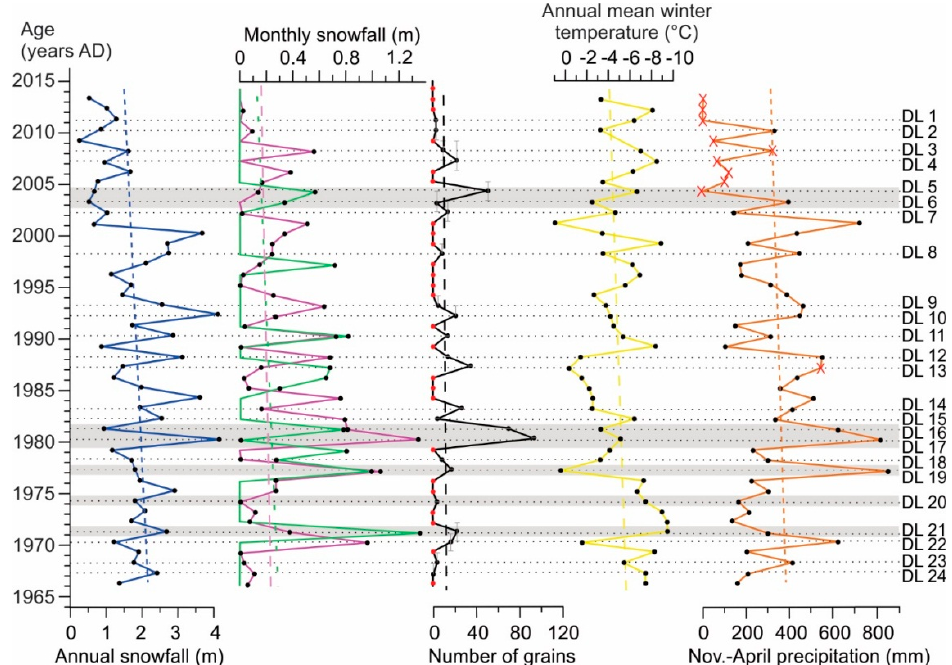
Figure 9. Correlation plot between climate data from Cooper Landing and Cooper Lake Project weather stations (Alaska Climate Research Center) and the snow-avalanche record derived from the sediment cores of Kenai Lake. From left to right: Total annual snowfall. Plots with monthly snowfall when (i) the mean monthly temperature is higher than 0 ◦ C (pink) and (ii) winter temperatures are variable: the mean monthly temperature is rising from November through January, or January and/or February mean temperature is higher than December and/or March average temperature (green). Total number of grains present in each debris lamina over all the cores, red dots indicate that no debris was found in that year. Mean winter temperature measured from December to March. Total precipitation from November to March, red crosses indicate incomplete records. Linear fits of the different plots are indicated by dashed lines. A few examples are highlighted of years with both debris in the cores and high amounts of snowfall during warm months or when the probability of melt-freeze crusts is high due to variable temperatures.